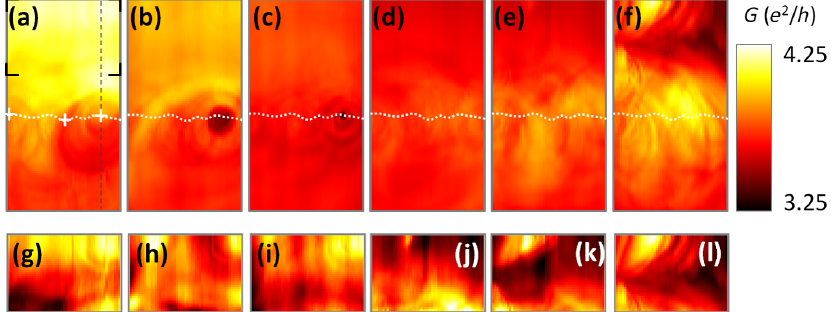
¼ 0 with tip voltages V ¼ (a) (cid:2) 10 : 0 , (b) (cid:2) 6 : 5 , (c) (cid:2) 3 : 5 , (d) þ 3 : 5 , back tip ¼ (cid:2) 8 : 0 V and (cid:1) G ¼ 0 : 15 e 2 =h . (i) V ¼ (cid:2) 6 : 5 V and (cid:1) G ¼ 0 : 15 e 2 =h . tip tip ¼ þ 8 : 0 V and (cid:1) G ¼ 0 : 40 e 2 =h . (l) V ¼ þ 10 : 0 V and (cid:1) G ¼ 0 : 85 e 2 =h tip tip